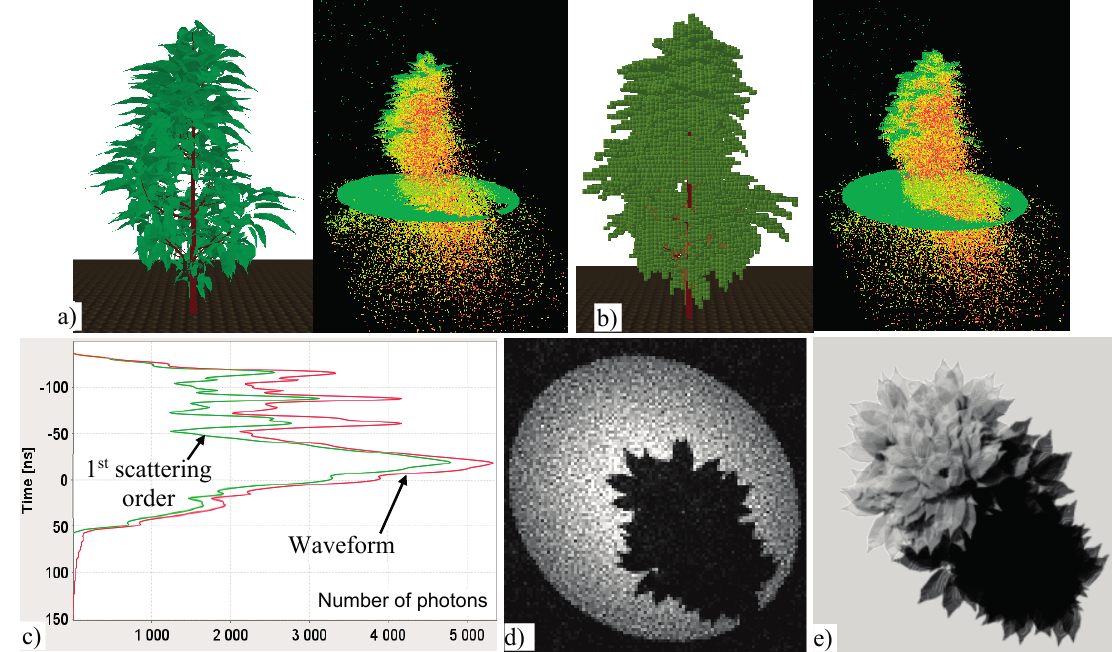
Figure 13. A virtual tree built out of geometrical facets ( a ) and the same turbid-cell tree derived by the facet-to-turbid conversion tool ( b ) with their 3D LIDAR point clouds for an oblique view (  = 30°,  = 135°) and the 1D waveform with its first scattering order contribution ( c ). The image of photons that reached the ground is showing the last LIDAR echo ( d ) and DART ray tracking provides a high spatial resolution (10 cm) nadir image at  = 1064